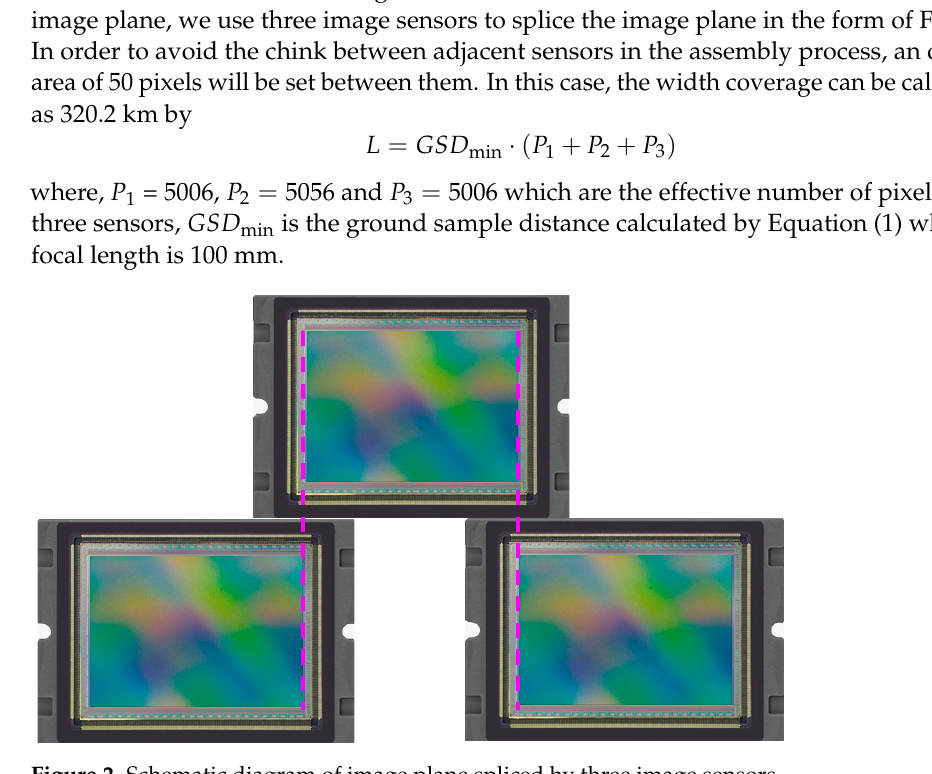
Figure 2. Schematic diagram of image plane spliced by three image sensors.